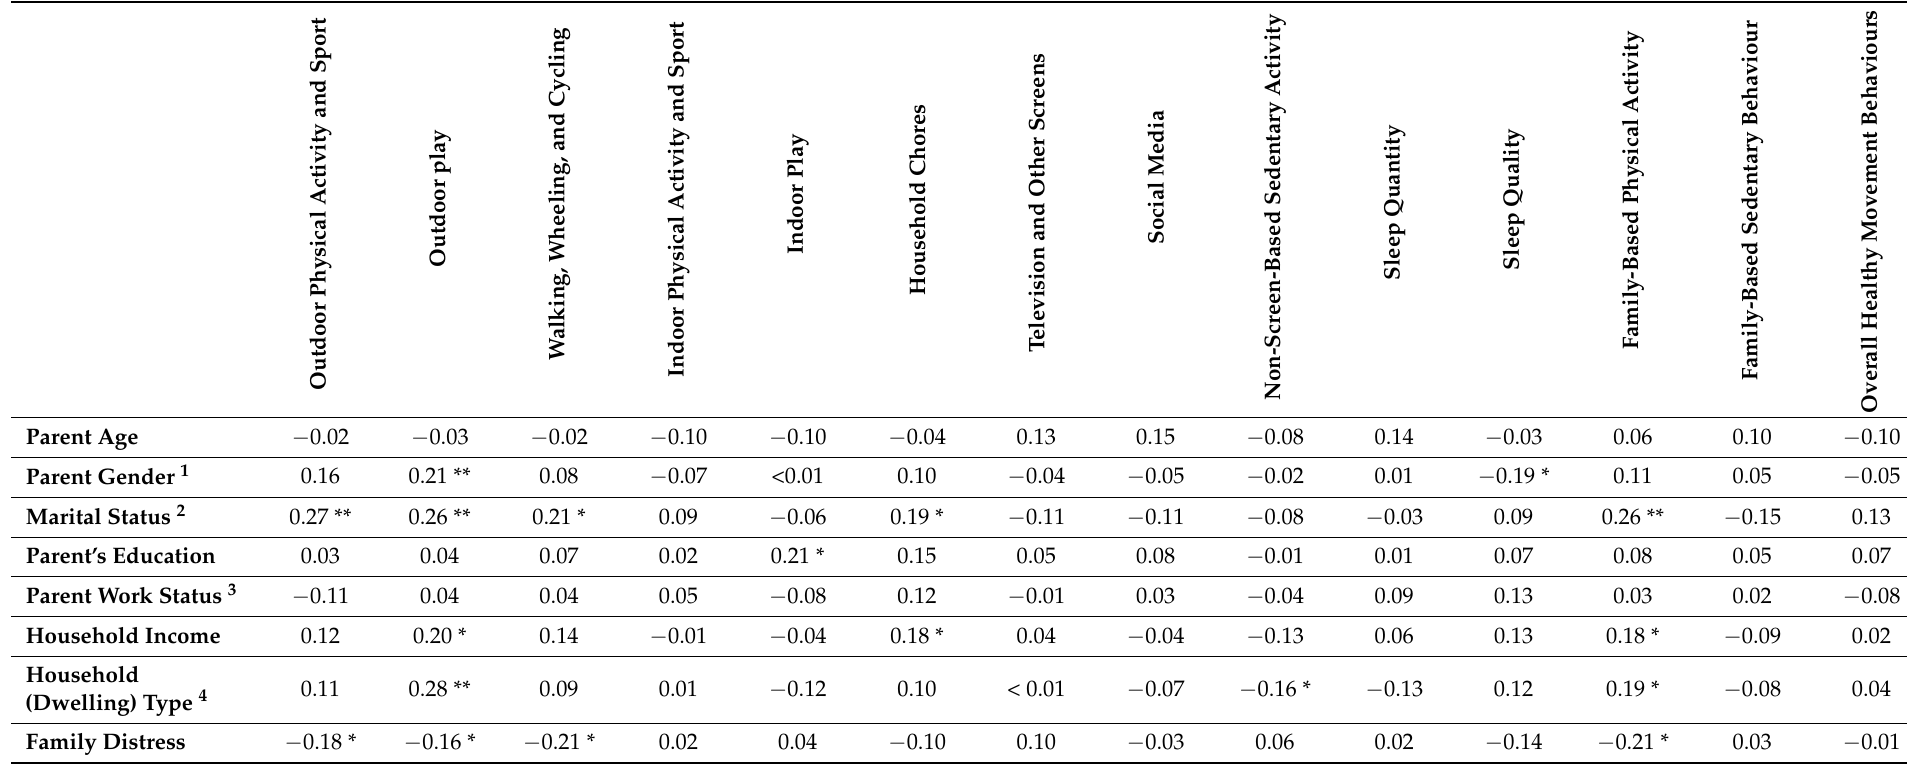
Table 4. Associations between parent demographics and parent-perceived changes in their child’s movement behaviours during the COVID-19 pandemic (May 2020; N =